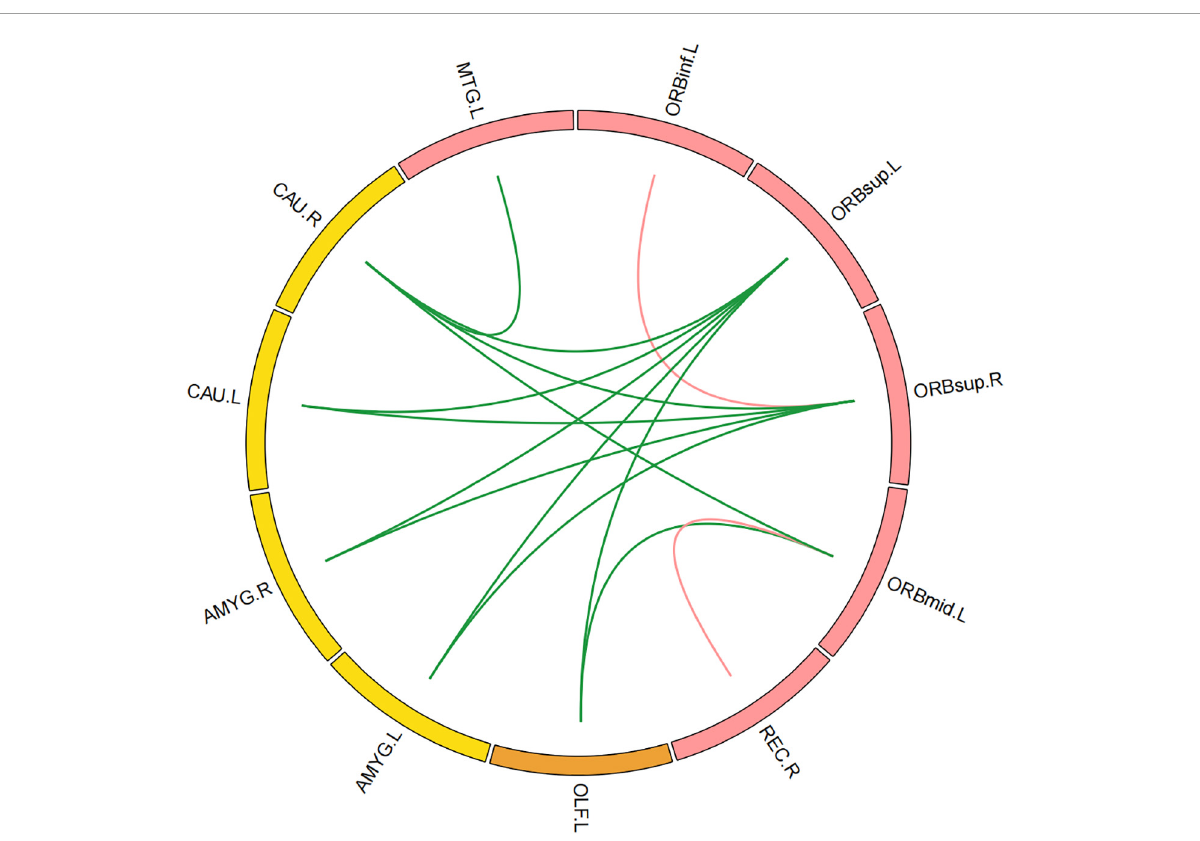
FIGURE1 Significant decrease in functional connectivity (FC). The red block represents the default mode network (DMN) regions; the yellow block represents the limbic/subcortical cortex regions; the orange block represents the olfactory cortex. The green line represents the functional connectivity originated from DMN regions; the red line represents the functional connectivity within DMN regions; ORBinf.L, left inferior orbitofrontal cortex; ORBsup.L, left superior orbitofrontal cortex; ORBsup.R, right superior orbitofrontal cortex; ORBmid.L, left middle orbitofrontal cortex; OLF.L, left olfactory cortex; REC.R, right gyrus rectus; MTG.L, left middle temporal cortex; AMYG.L, left amygdala; AMYG.R, right amygdala; CAU.L, left caudate; CAU.R, right